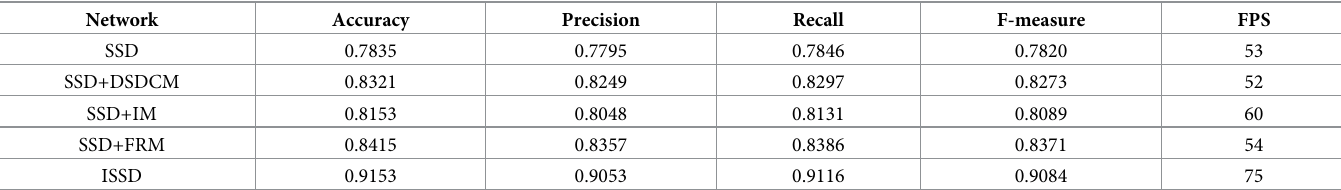
Table 4. Validation results of components in the ISSD.